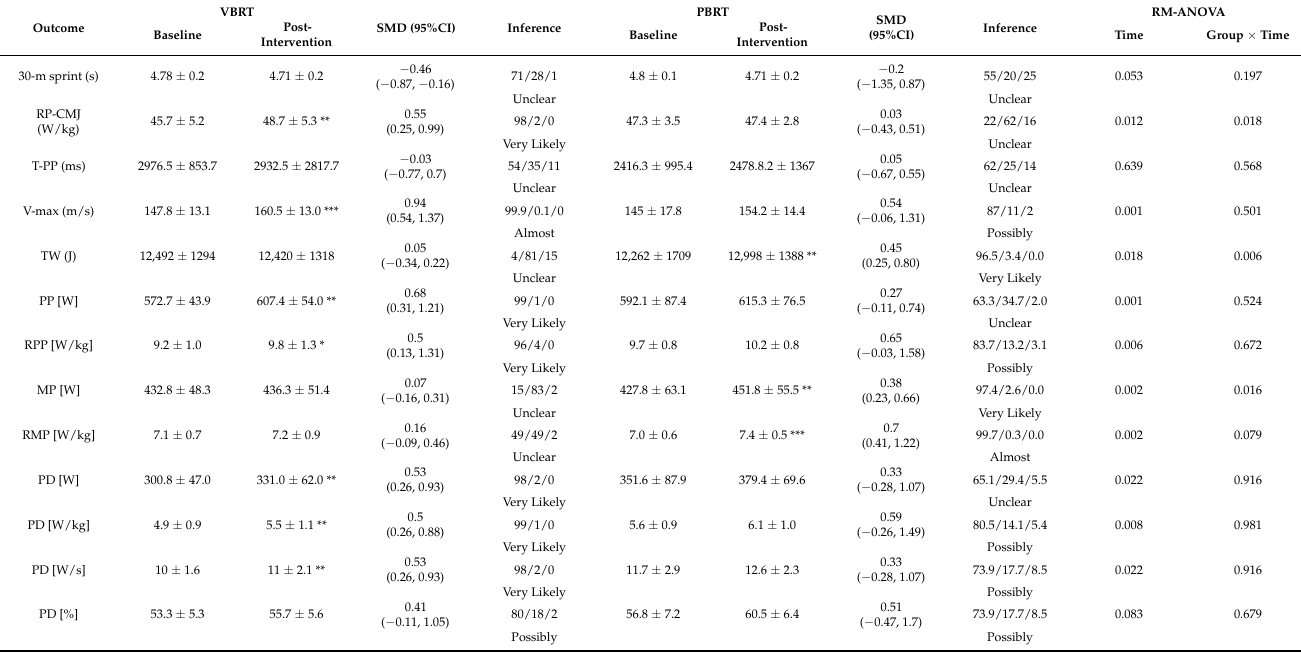
Table 3. Results of mechanisms of lower limb muscle anaerobic performance adaptation between VBRT and